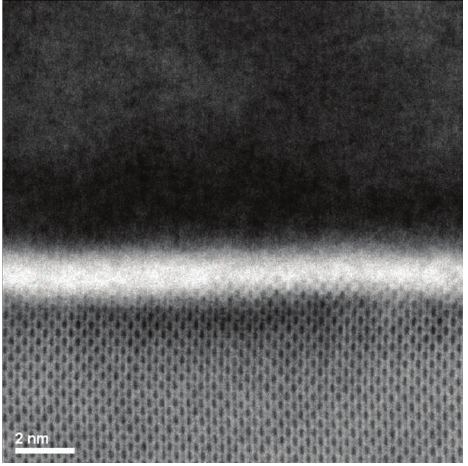
Figure 4: STEM (bright field) image of the TiO 2 film showing an interface layer between the top TiO 2 film and the c-Si substrate.